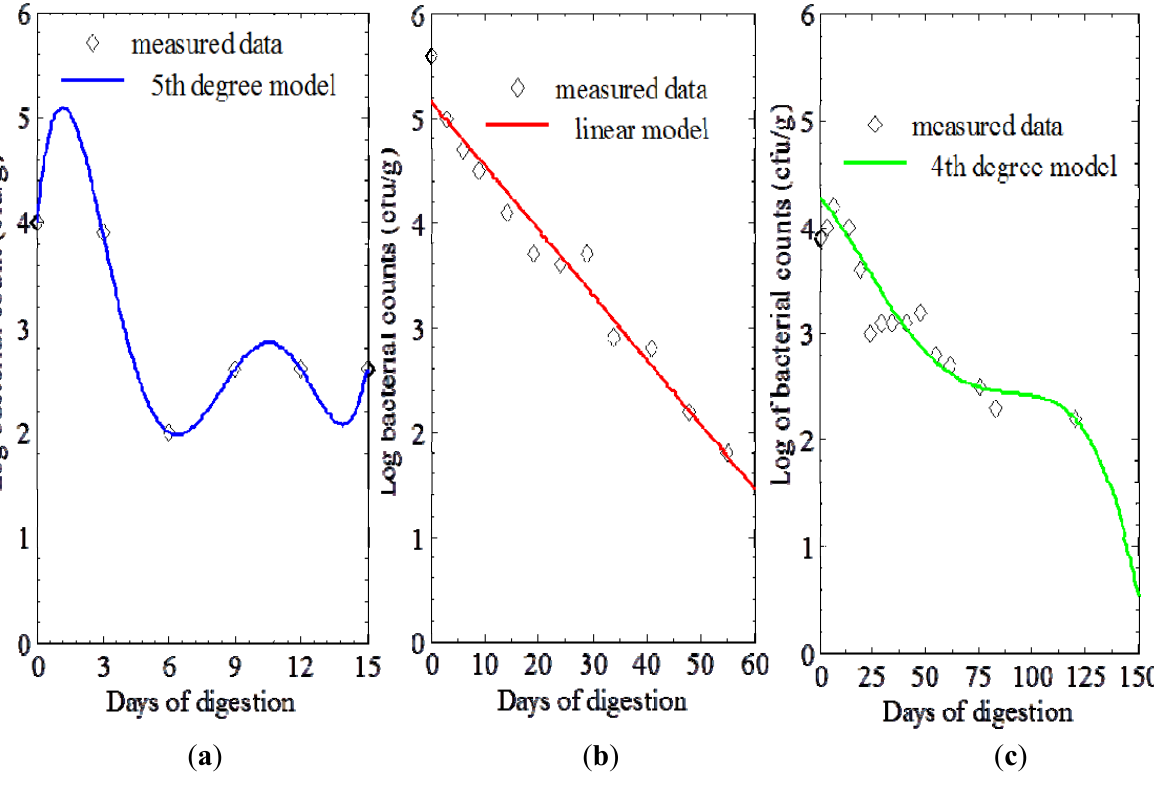
Figure 2. ( a ) Reduction of Campylobacter sp. counts with retention time. ( b ) Reduction of E. coli counts with retention time. ( c ) Reduction of Salmonella sp. counts with retention